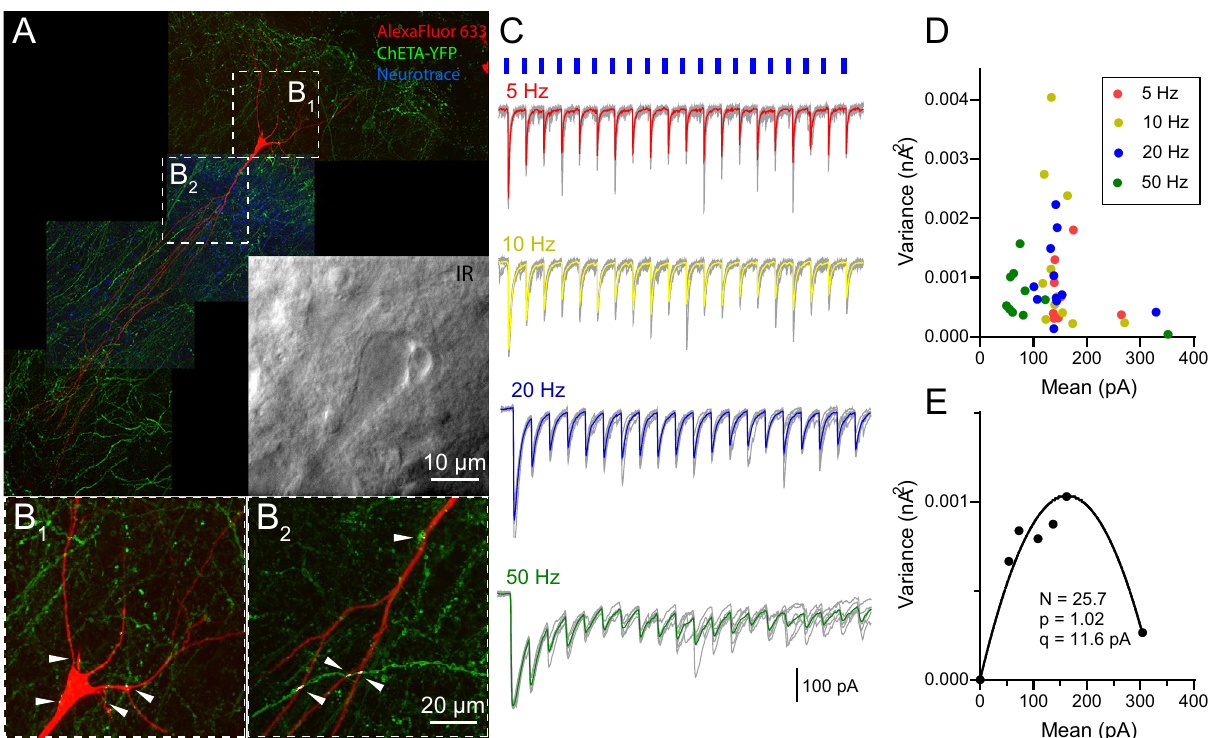
Figure 6. Hippocampal PV-mediated ( PV HC ) transmission onto a CA1 pyramidal cell (PC). ( A ) Flat-projected confocal image displaying (red) a post-hoc biocytin-filled CA1 PC and (green) ChETA-YFP-containing PV HC fibers and terminals, counterstained with (blue) Neurotrace 435/455. Inset, Live IR Dodt contrast image of the recorded CA1 PC. ( B1 , B2 ) Expanded images from dotted boxes in A, showing co-localization (white) of (green) ChETA-YFP PV HC terminals and (red) the recorded CA1 PC. Representative light pulse trains (1 ms duration, 20 pulses (P1–P20), repeated 7 times) at ( C ) 5 Hz, ( D ) 10 Hz, ( E ) 20 Hz, and ( F ) 50 Hz (raw traces, grey; average, colored). ( G ) The variance (V) and peak mean (M) was computed for each pulse in each pulse train in ( C – F ). In G, 20 raw VM points are displayed for (red) 5 Hz, (yellow) 10 Hz, (blue) 20 Hz and (green) 50 Hz conditions, with each point representing the M and V of 7 individual IPSCs from P1–P20. ( H ) VM plots from G are binned in 20 pA increments. The VM relationship was fit by a parabolic function (see “Methods” and Fig. 3 legend), enabling estimation of the number of functional release sites (N), release probability (p), and average quantal amplitude